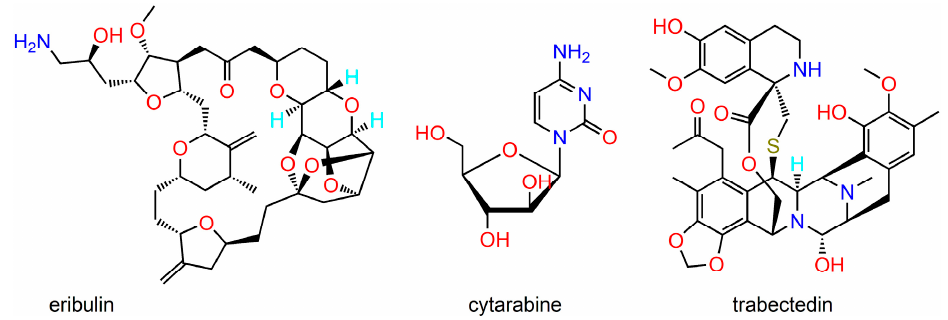
Figure 3. Selected structures of marine compounds with antineoplastic activity.